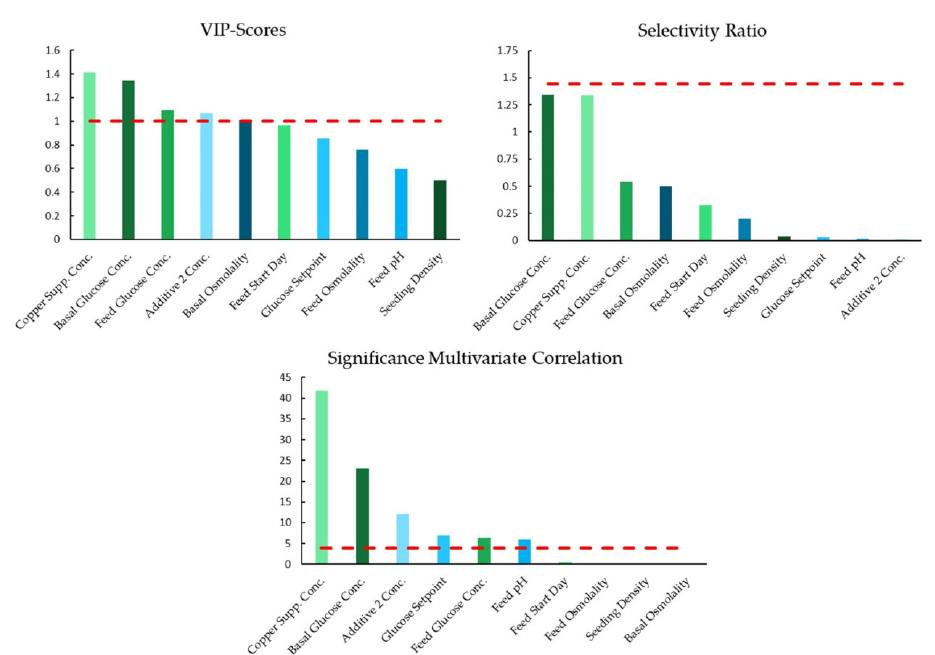
Figure 5. Plots showing the values of the variable importance metrics calculated from the PLSR model predicting the complex afucosylation level of mAb- δ . The red dashed line indicates the significance threshold of the metric. Each different parameter is represented by a unique colored bar.